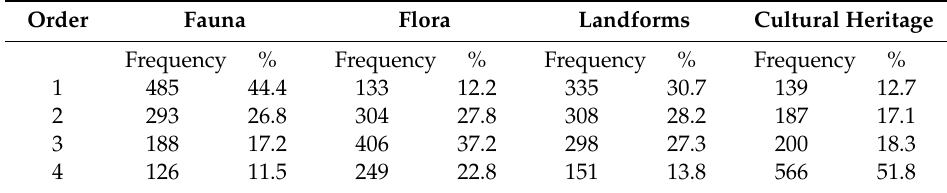
Table 6. Preferential ordering in responses to questions 1 to 6.